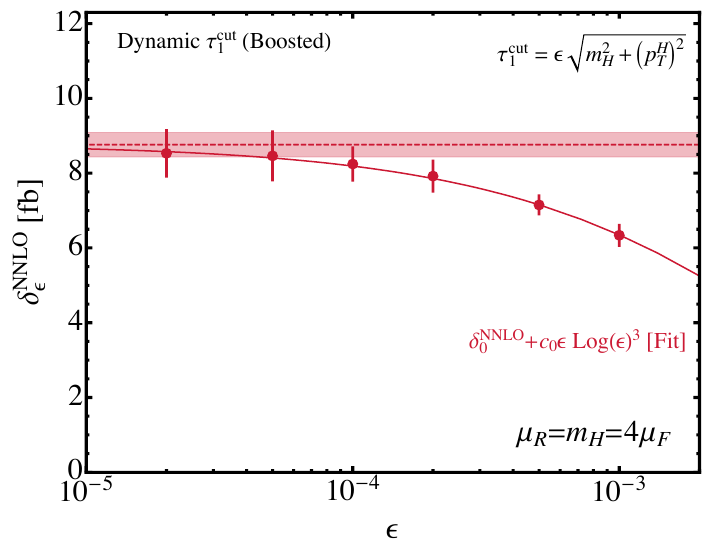
Figure 5 . The τ cut dependence of the NNLO coefficient for H + j production at the 13 TeV LHC. 1 Results are presented for the dynamic version of τ cut , evaluated in the rest frame of the H + j 1 system. Also shown is a fit to the results parametrizing the residual (cid:15) ( τ cut ) power corrections. 1 The dashed line corresponds to the limit (cid:15) → 0 of the fit, and the shaded band represents fitting uncertainties on the asymptotic